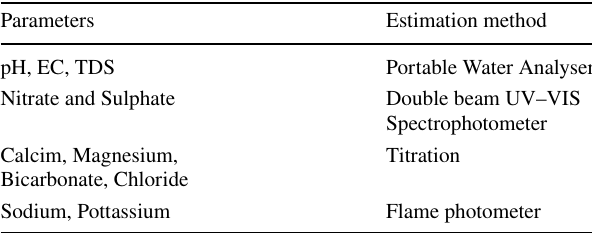
Table 1 Estimation method used for different parameters